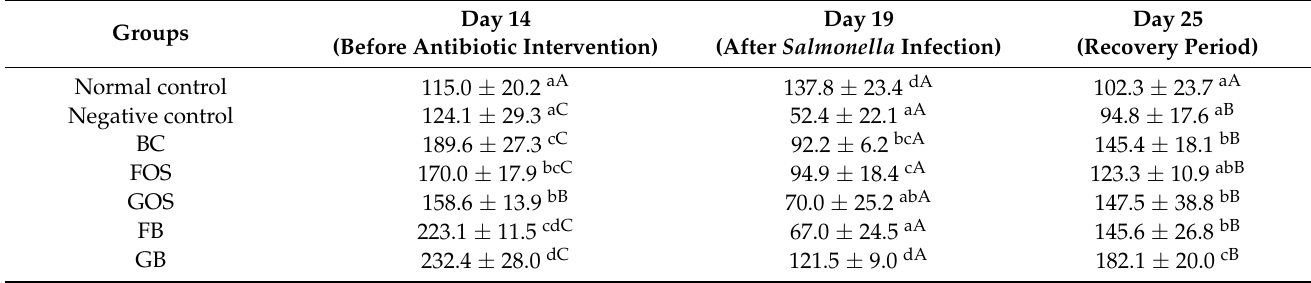
Table 2. The total concentrations of fecal short-chain fatty acids ( µ mol/g) at different times. Day Groups